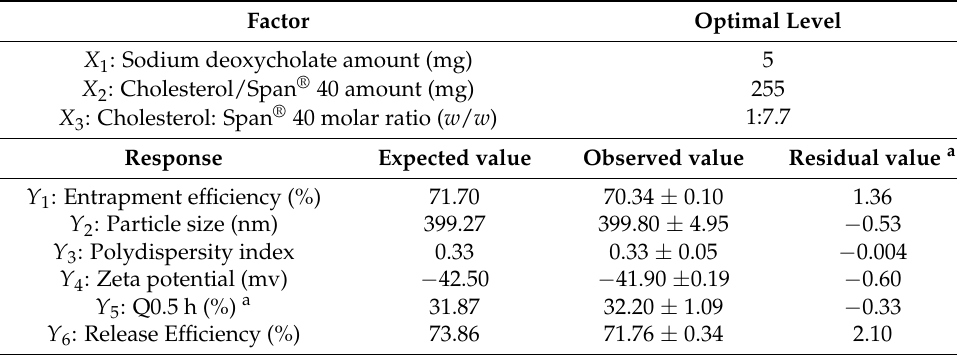
Table 5. Optimal levels of factors of the suggested zolmitriptan-loaded bilosomes with the expected, observed and residual values of each